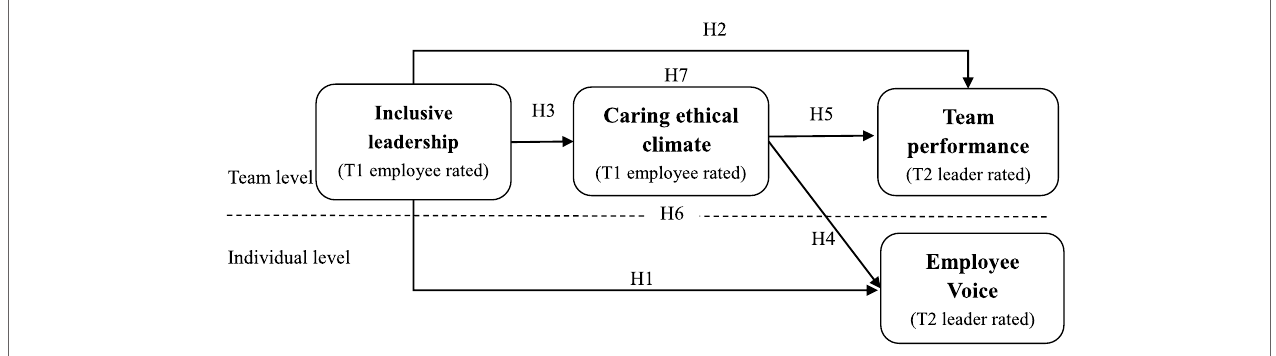
FigUre 1 | Research